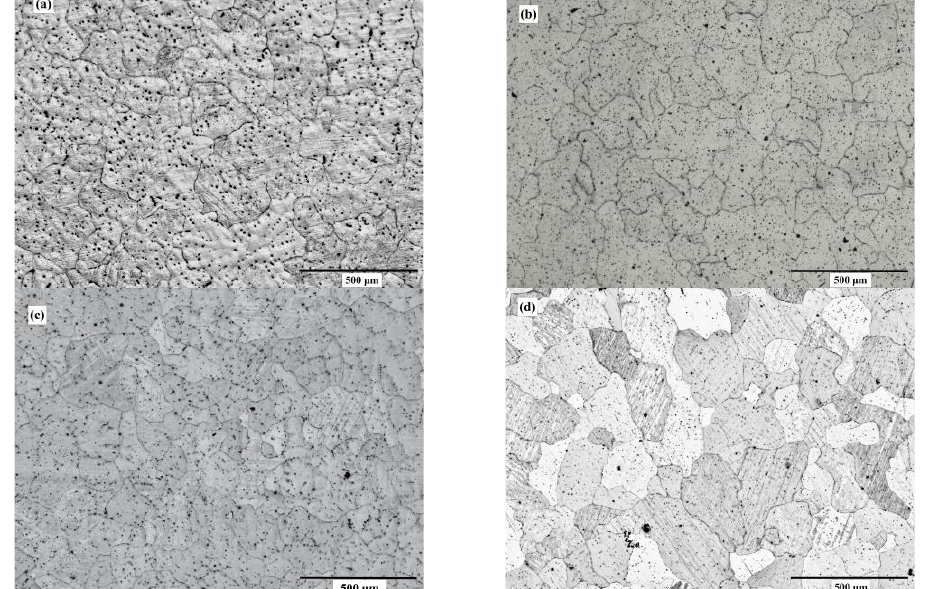
Figure 3. Optical microstructures of ( a ) ZX10 alloy, ( b ) ZX10-0.5ND, ( c ) ZX10-1ND, and ( d ) ZX10-2ND.